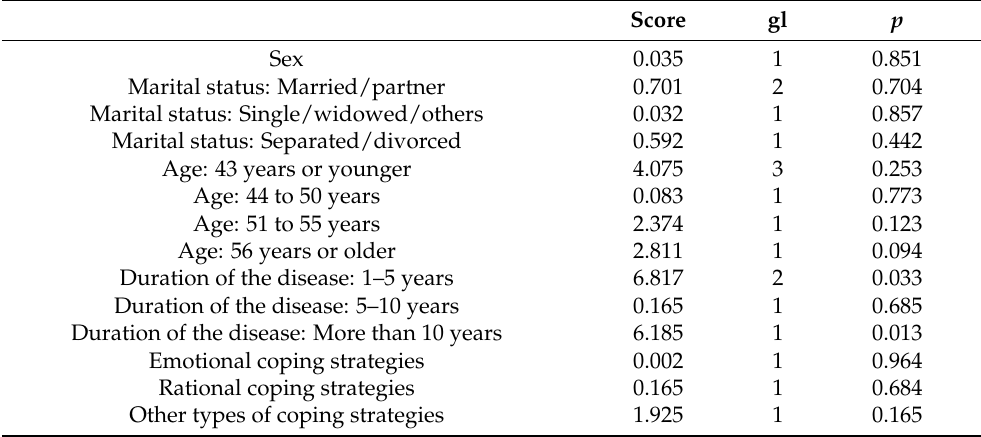
Table 6. Variables not included in the null model. Diabetes Mellitus sujects.